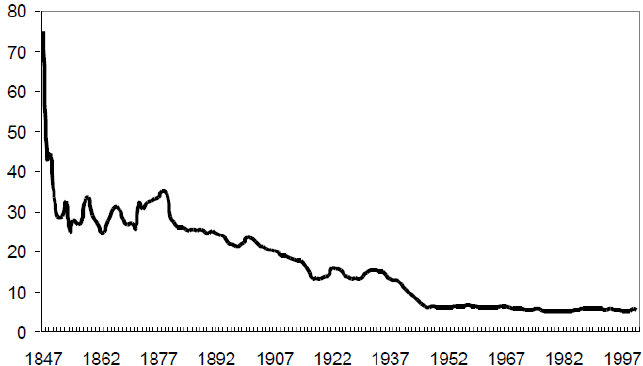
Figure 1. Average Capital/Asset Ratio of Commercial Banks Europe 1847–2001. Source: Benink and Benston (2005).